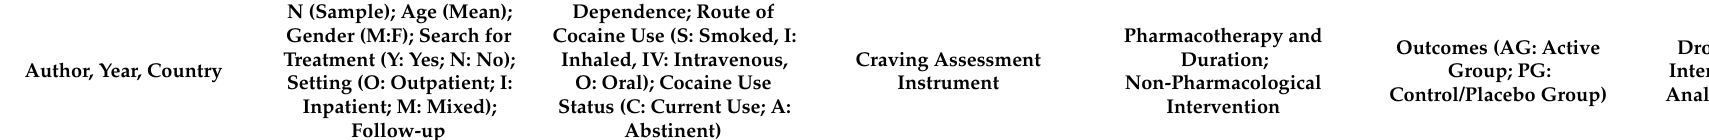
Table 1. Characteristics and main findings of the studies included in the systematic